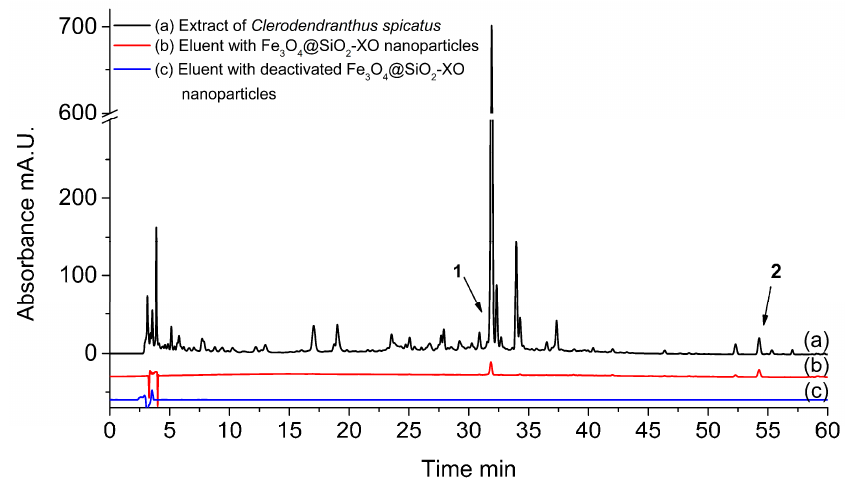
Figure 6. The chromatograms of (a) extract of Clerodendranthus spicatus, (b) eluent with Fe 3 O 4 @SiO 2 -XO nanoparticles and (c) eluent with deactivated Fe 3 O 4 @SiO 2 -XO nanoparticles.